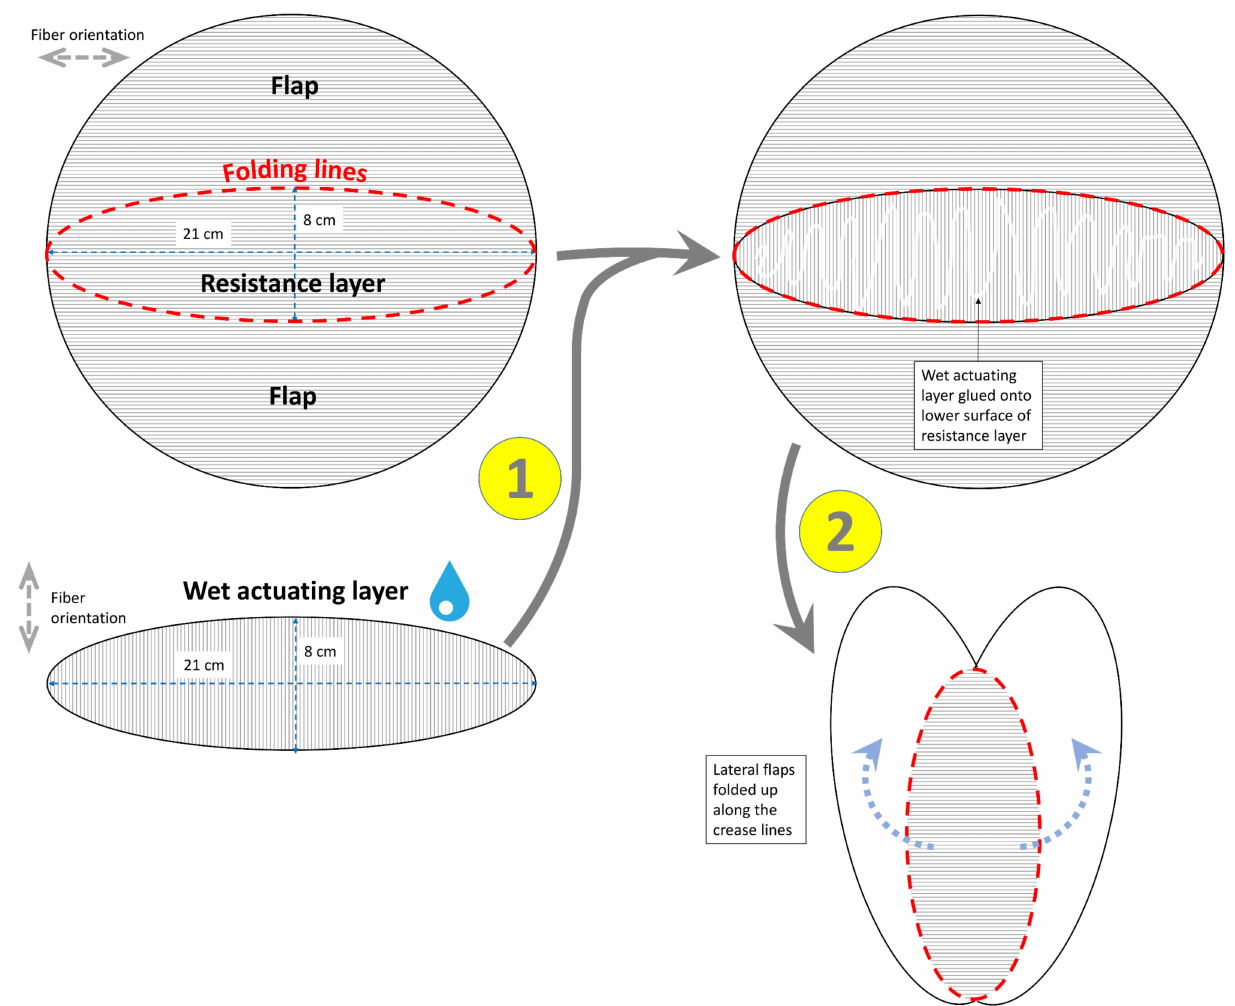
Figure 4. Exemplary construction scheme for the abstraction of the A. vesiculosa snap-trap and its transfer into a paper-based self-actuated compliant system. The various construction steps are numbered (1, 2). The fiber orientations of the dry RL and wet AL are indicated (gray dashed arrows). Details are provided in the main